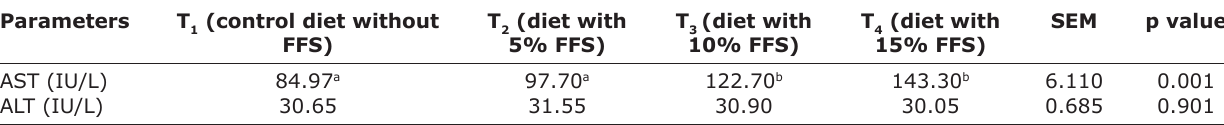
Table-7: Effect of dietary supplementation of FFS on serum enzymatic profile (mg/dl) of broiler Japanese quails at 5 weeks of age.